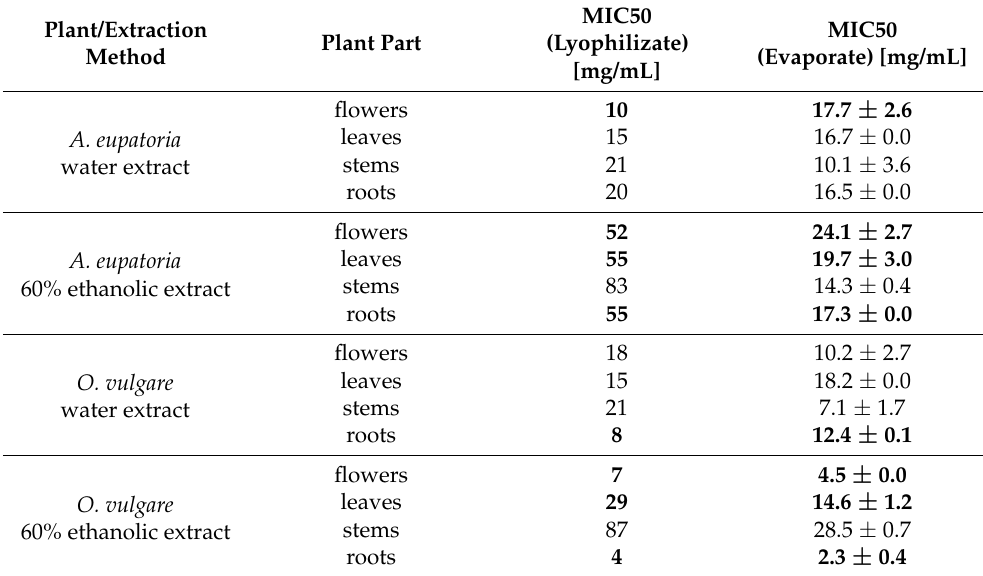
Table 1. Minimal inhibitory concentration (MIC50) values of water or 60% ethanolic extracts of A. eupatoria and O. vulgare